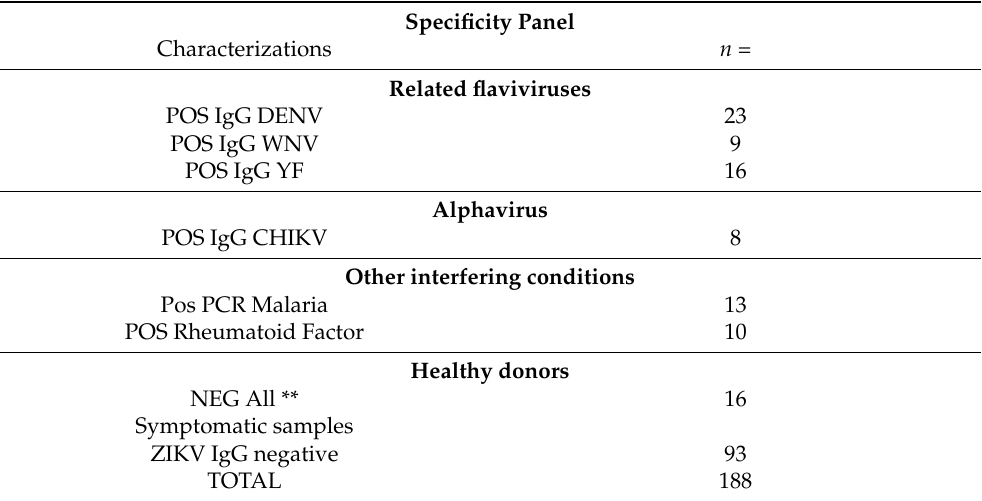
Table 1. Description of the specificity panel used for the evaluation.